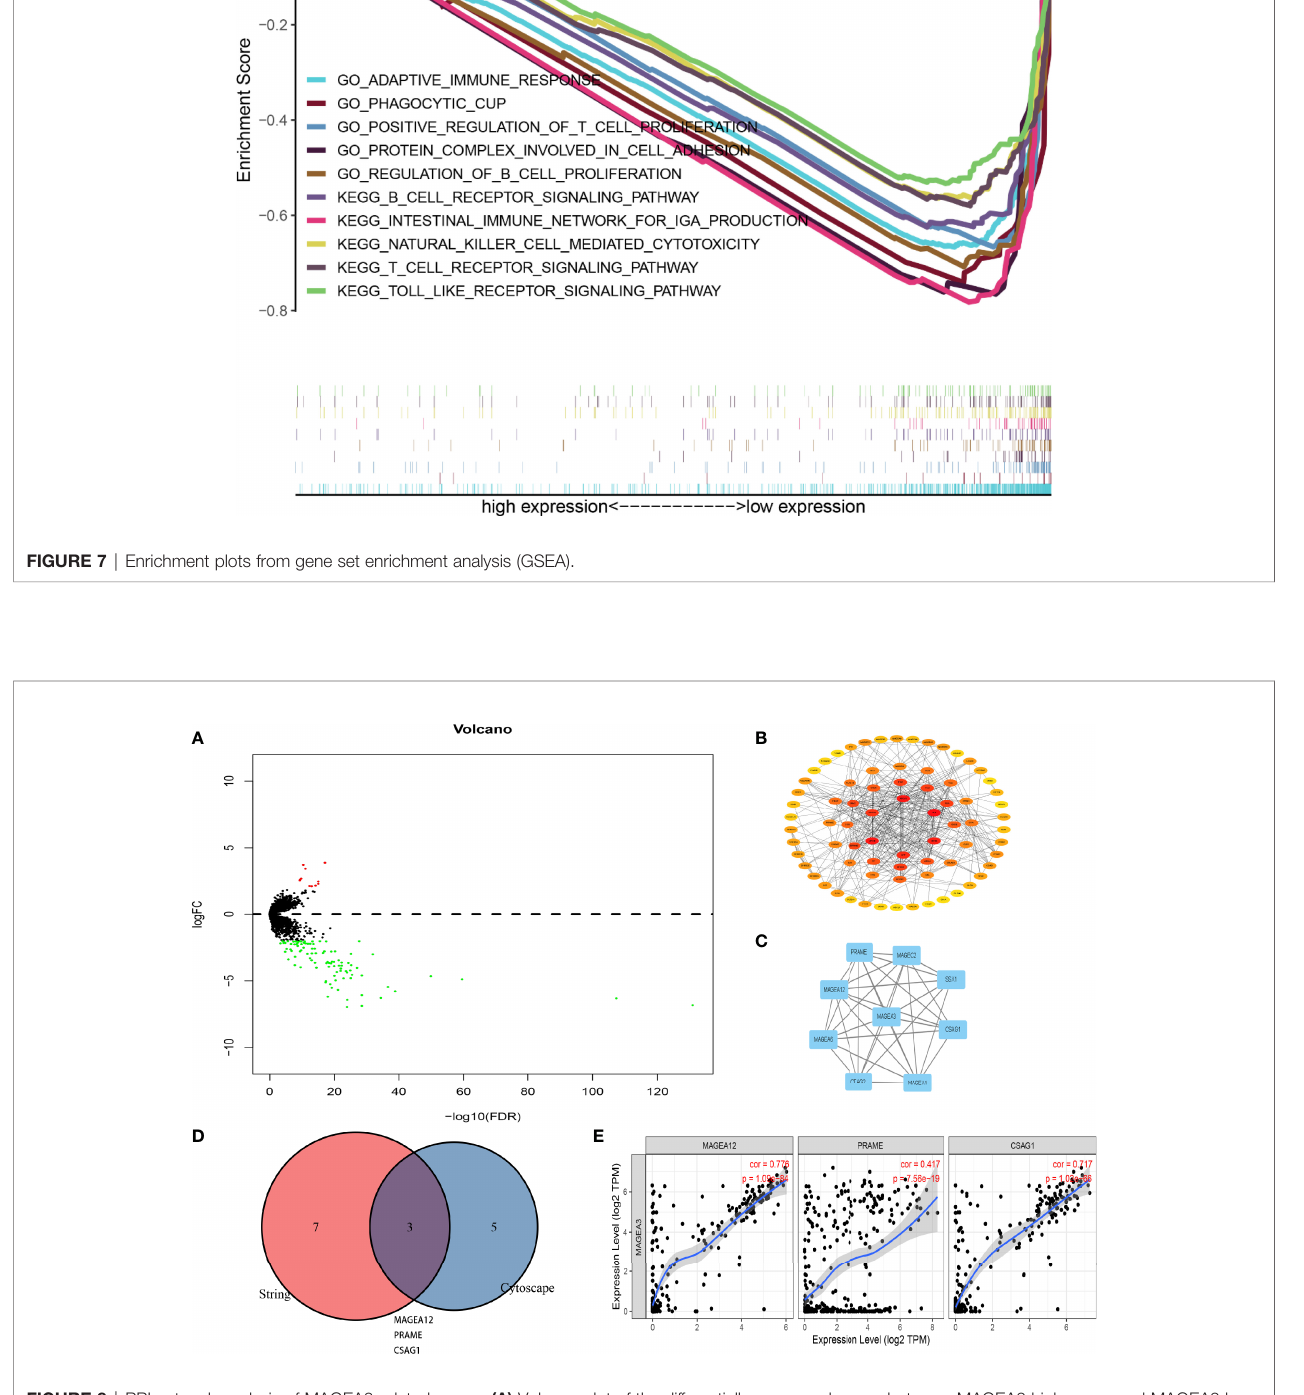
FIGURE 8 | PPI network analysis of MAGEA3-related genes. (A) Volcano plot of the differentially expressed genes between MAGEA3 high group and MAGEA3 low group. (B) PPI structureof co-expressed genes. (C) The top module involved MAGEA3 identi fi ed by MCODE plugin in Cytoscape. (D) An intersection analysis of the MAGEA3-binding and correlated genes was conducted. (E) Correlation analysis between MAGEA3 expressed and screened common genes, including MAGEA12, PRAME, and